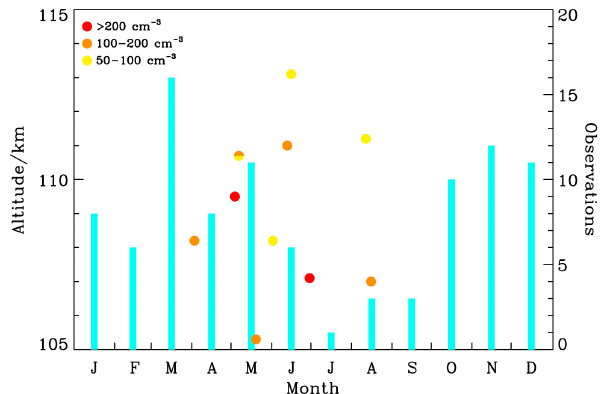
Figure 10. Na density at Qingdao (36 ◦ N) on logarithmic scales. For further explanation please see